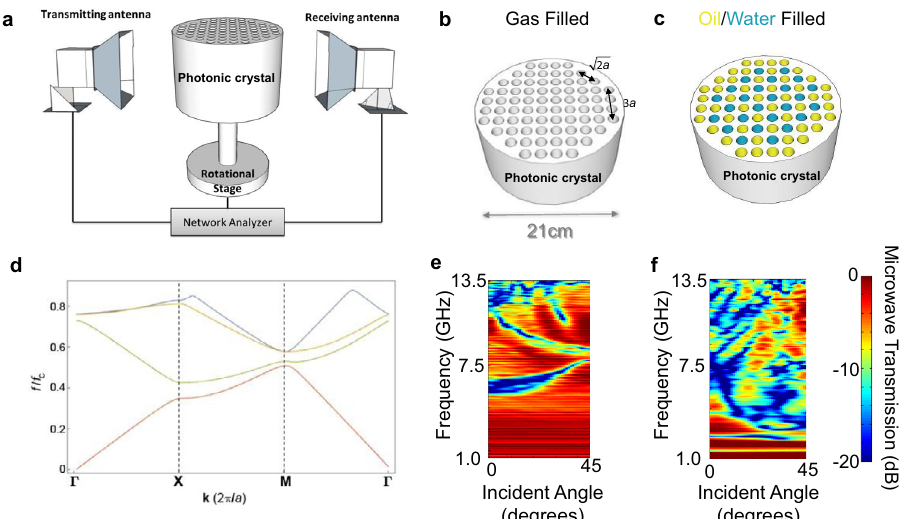
Fig. 1 Concept of utilizing photonic crystal to detect multiphase materials. a Lab-scale experimental con fi guration with the transmitting and receiving antenna on opposite sides of the photonic crystal (PC). Both antennas are connected to a network analyzer (see methods). The PC is placed on top of a plastic rod that is connected to a rotational stage. b An illustration of the photonic crystal with multitude of holes arranged in a square lattice con fi guration; In this case the holes are fi lled with air. Here a is the lattice constant. c An illustration of the same photonic crystal structure with a proportion of the holes fi lled with water (blue) and the remaining holes fi lled with oil (yellow). d Computed photonic band structure of the square lattice ( fi rst four eigenmodes are shown, sequentially as red, green, yellow and blue curves). Here k is the wave vector and a is the lattice constant. The symmetry points in the fi rst Brillouin zone are shown on the x -axis, ( Γ , X , and M ) and the y-axis is the frequency f normalized by the characteristic frequency f c . e , f Color contour plots of the microwave transmission measurements through the structures shown in b and c , respectively. The x -axis is incident angle, with zero de fi ned as the X symmetry point in d or equivalently vertical direction of b . Increasing incident angles indicates rotating in clock-wise direction. The y -axis is microwave frequency. The color in e and f corresponds to the microwave transmission coef fi cient as indicated in the accompanying scale bar.